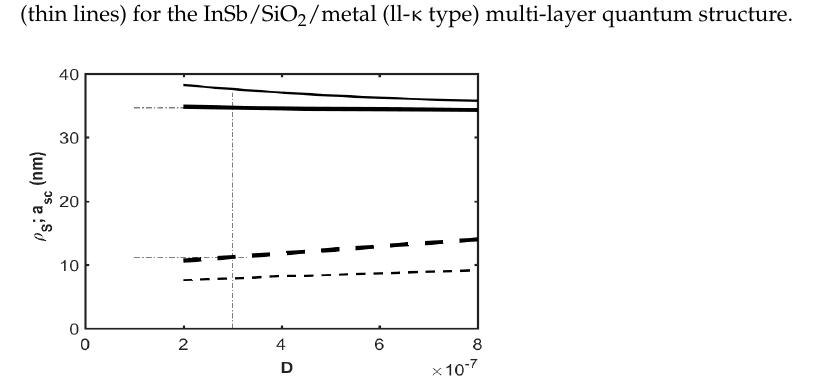
4 numerical data. Figure 5. Binding energy E sll-k of the screened impurity state as a function of the oxide thickness D with the n s / T | a ≈ 6.6x10 7 cm − 2 / 0 K parameter (bold line) and n s / T | b ≈ 6.6x10 8 cm − 2 / 0 K parameter (thin line) for the InSb/SiO 2 /metal (ll- κ type) multi-layer quantum structure. As shown in Figure 5, the binding energy E sll-k values increase in parallel with the oxide thickness D , but the growth rates in cases (a) and (b) are quite different. In the first case, the binding energy grows significantly, increasing for the InSb bulk sample from values E s ≈ 0.66 meV (marked by a horizontal dashed-dotted line in the figure) at the oxide thickness D ≈ 2.84x10 − 7 nm (marked by a vertical dashed-dotted line) to an almost fourfold increased value ≈ 2. 52 meV (marked by a horizontal dashed-dotted line) at thickness D ≈ 6.75.10 − 7 nm (marked by a vertical dashed-dotted line), for which the effective radii have equal values ( ɑ sc = ρ s = 23.74 nm in accordance with Figure 3). With the oxide thickness range D ϵ (3 ÷7 nm), the E sll-k ( D ) functional dependence might be quite satisfactorily char- acterized as linear growth, as demonstrated in the graph by the dashed line. The latter, as can be clearly seen from the graph, should no longer be attributed to case (b), where the increase in the binding energy is obviously slower and, in terms of magnitude, differs slightly from the InSb bulk sample result E s ≈ 0.66 meV starting from the D > 5.33.10 − 7 nm value (marked by a vertical dashed-dotted line in Figure 5). This fully corresponds to